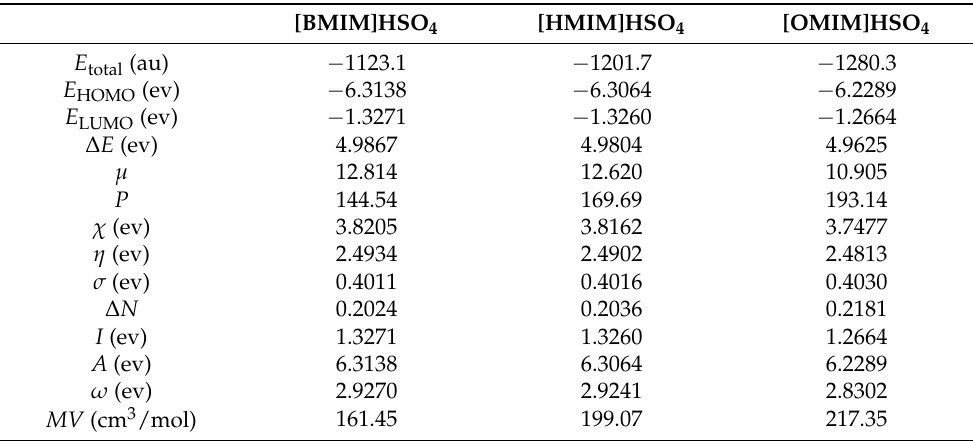
Table 1. Fourteen reactive parameters of three ILs in the gas phase obtained by